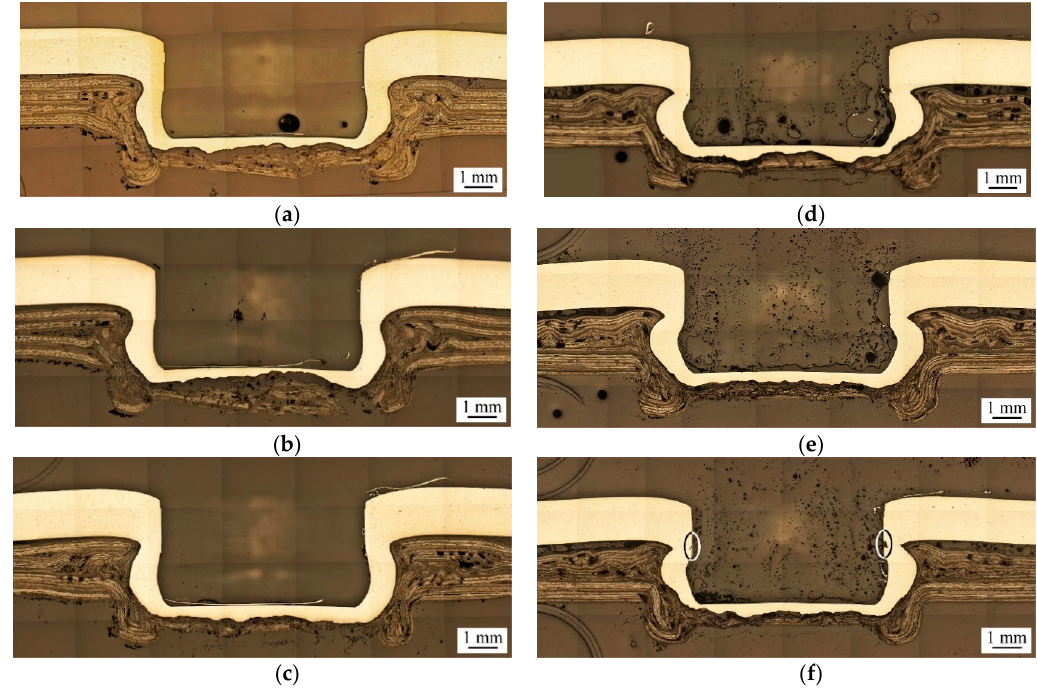
Figure 7. Cross-sectional micrographs of clinch joints made under Heating Mode A with ( a ) 69 kN, ( b ) 70 kN, ( c ) 75 kN punching forces, and Heating Mode B with ( d ) 69 kN, ( e ) 70 kN, ( f ) 75 kN punching Figure 1. Die D1 and heating temperature of 100 °C are used.